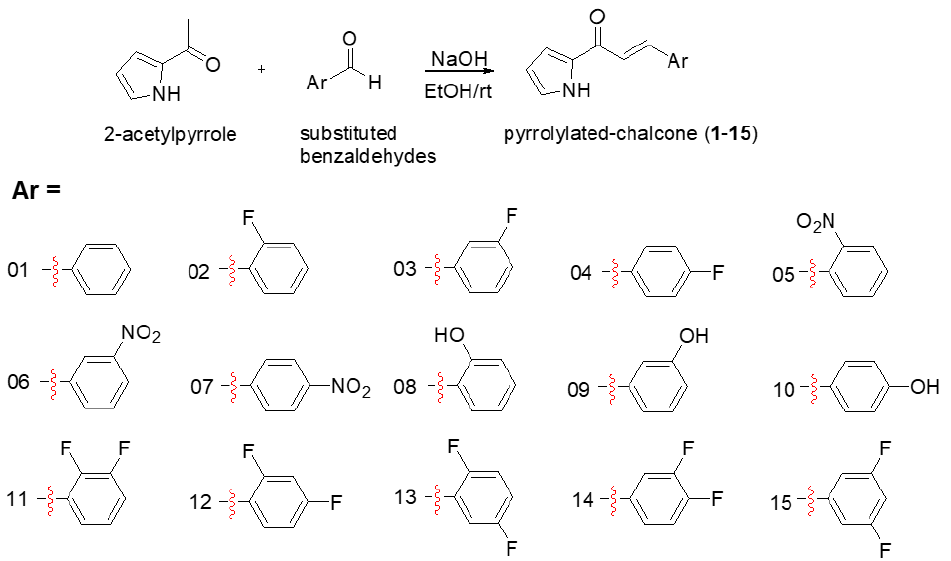
drug-likeness properties (Table S2) of the synthesized molecules ( 1 – 15 ) were appended in Supplementary